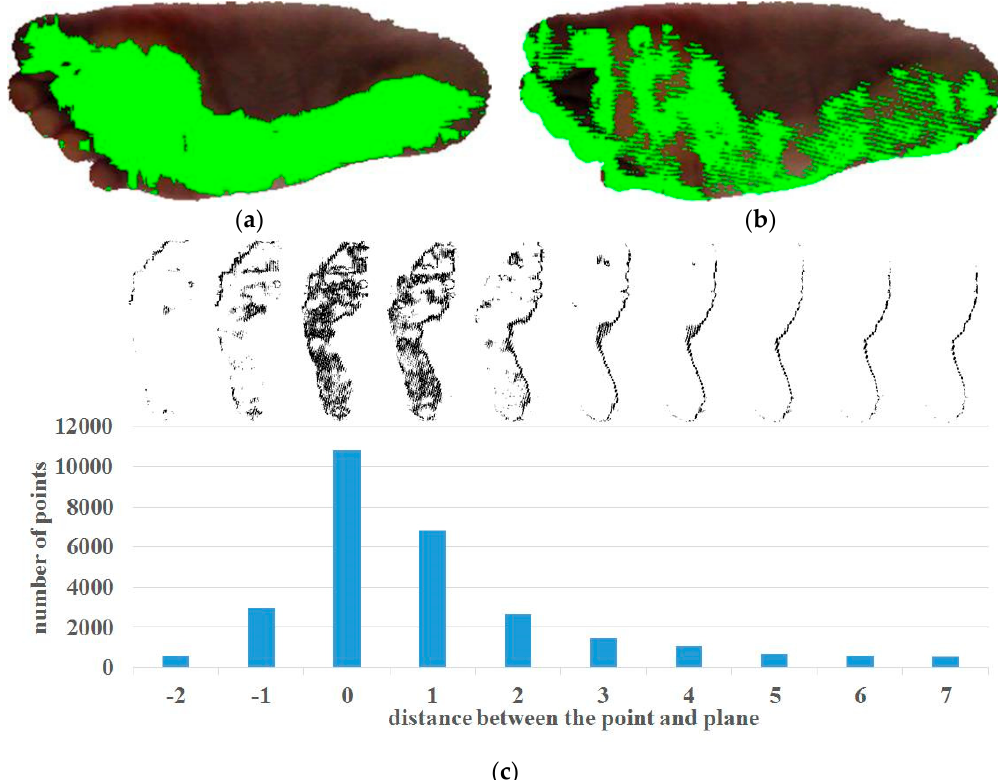
Figure 5. Contact point detection process: ( a ) foot points included in the largest normal vector cluster (green points), ( b ) detected contact points (green points), ( c ) number of corresponding points according to distance from the plane.